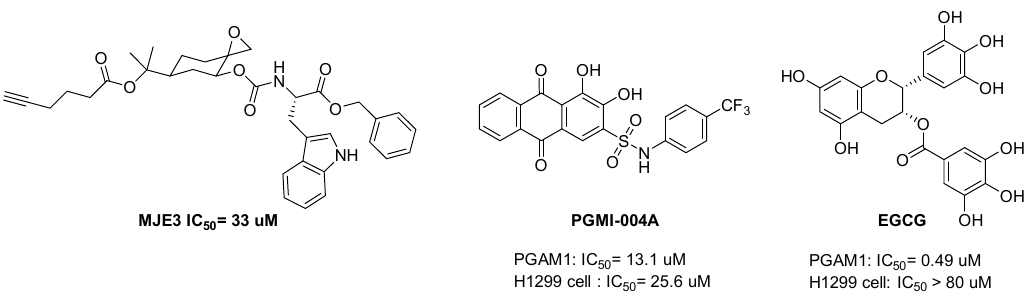
Figure 1. The inhibitors of PGAM1. Recently, starting from the PGMI-004A, we conducted scaffold hopping and a sulfonamide reversal strategy to discover a series of 1,2,8-trihydroxy xanthone derivatives as novel PGAM1 inhibitors (Figure 2). The inhibitory activities both on the enzymatic and cellular level of those xanthone derivatives were significantly improved compared to PGMI-004A [22]. Besides, the xanthone core as an important scaffold with diverse biologic activities, such as antitumor, antioxidant, anti-inflammation, etc., was of documented relevance to human diseases [23–27]. In this paper, maintaining the xanthone scaffold and considering that the ortho -dihydroxy phenol moiety might cause metabolic instability [28], we removed the C2-hydroxy group to design and synthesize a series of new N -xanthone benzenesulfonamides. What is more, the SAR of the A-ring has also been explored.